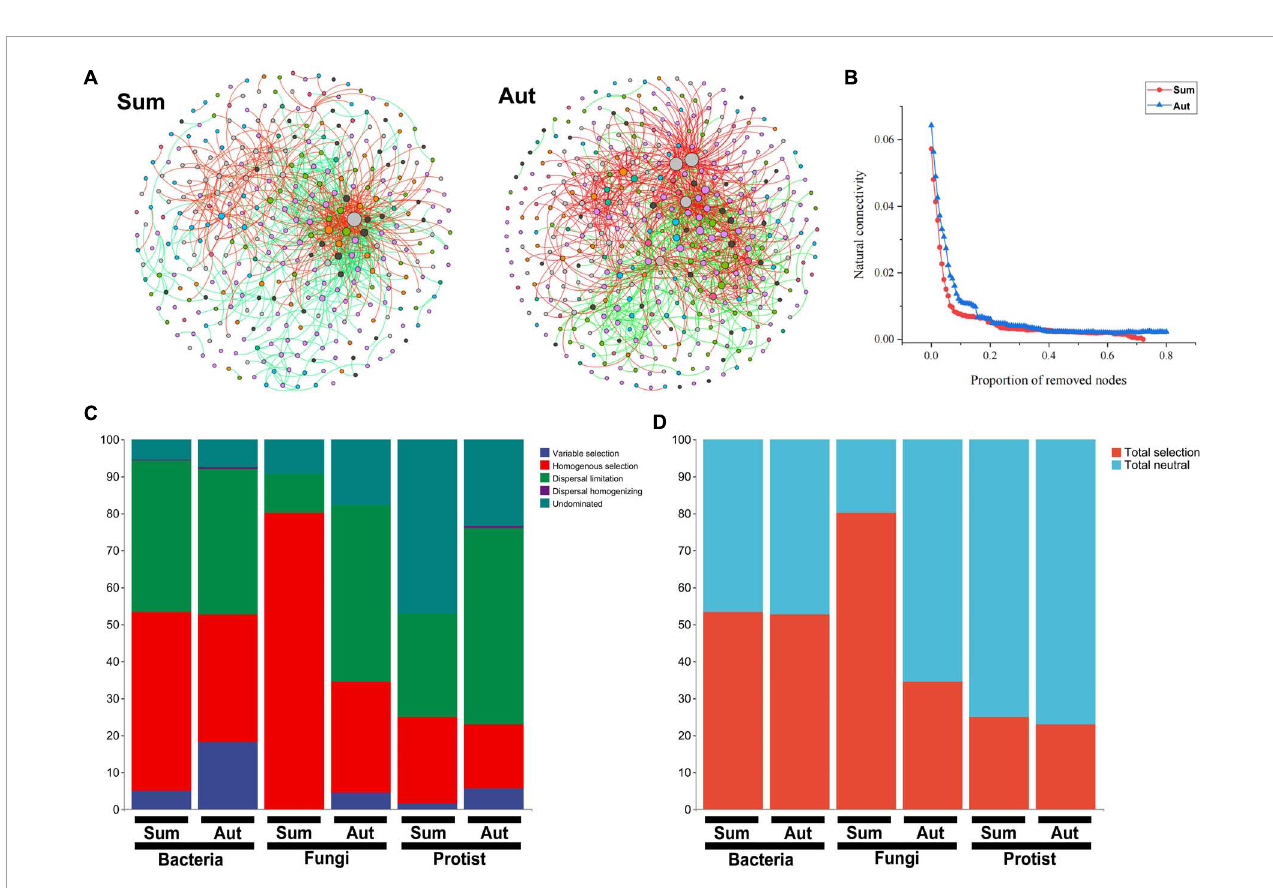
FIGURE5 The inter-kingdom association network patterns and assembly of the microbial community in summer and autumn. (A) A network of soil microbial amplicon sequence variants (ASVs) found in summer and autumn based on correlations. Each node represents an ASV, and the edges connecting nodes represent either positive (red) or negative (black) correlations inferred using the SparCC approach using ASVs abundance profiles (pseudo p < 0.05, correlation values < – 0.6 or > 0.6). (B) Network stability in summer and autumn. (C) The relative contribution (%) of five ecological processes. (D) The relative contribution (%) of determinism and stochasticity on the microbiome assembly based on the β -Nearest Taxon Index ( β NTI) values. Sum, summer; Aut,